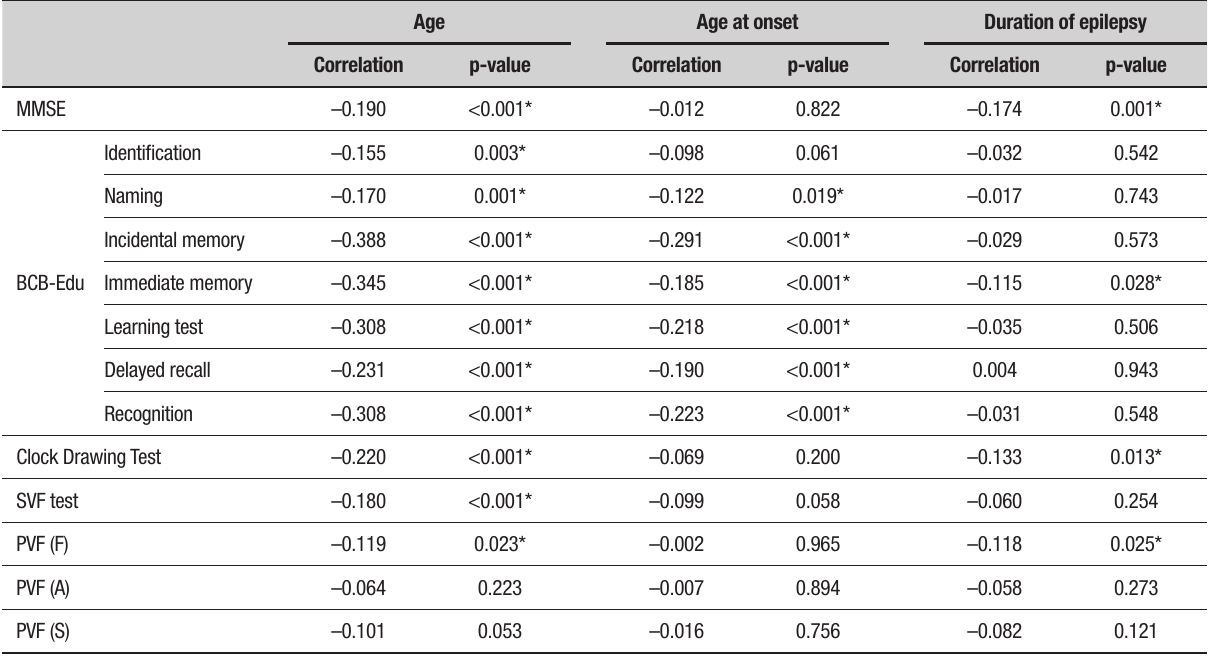
Table 4. Correlation of Mini-Mental State Examination and Brief Cognitive Battery-Edu scores with age, age at onset and duration of